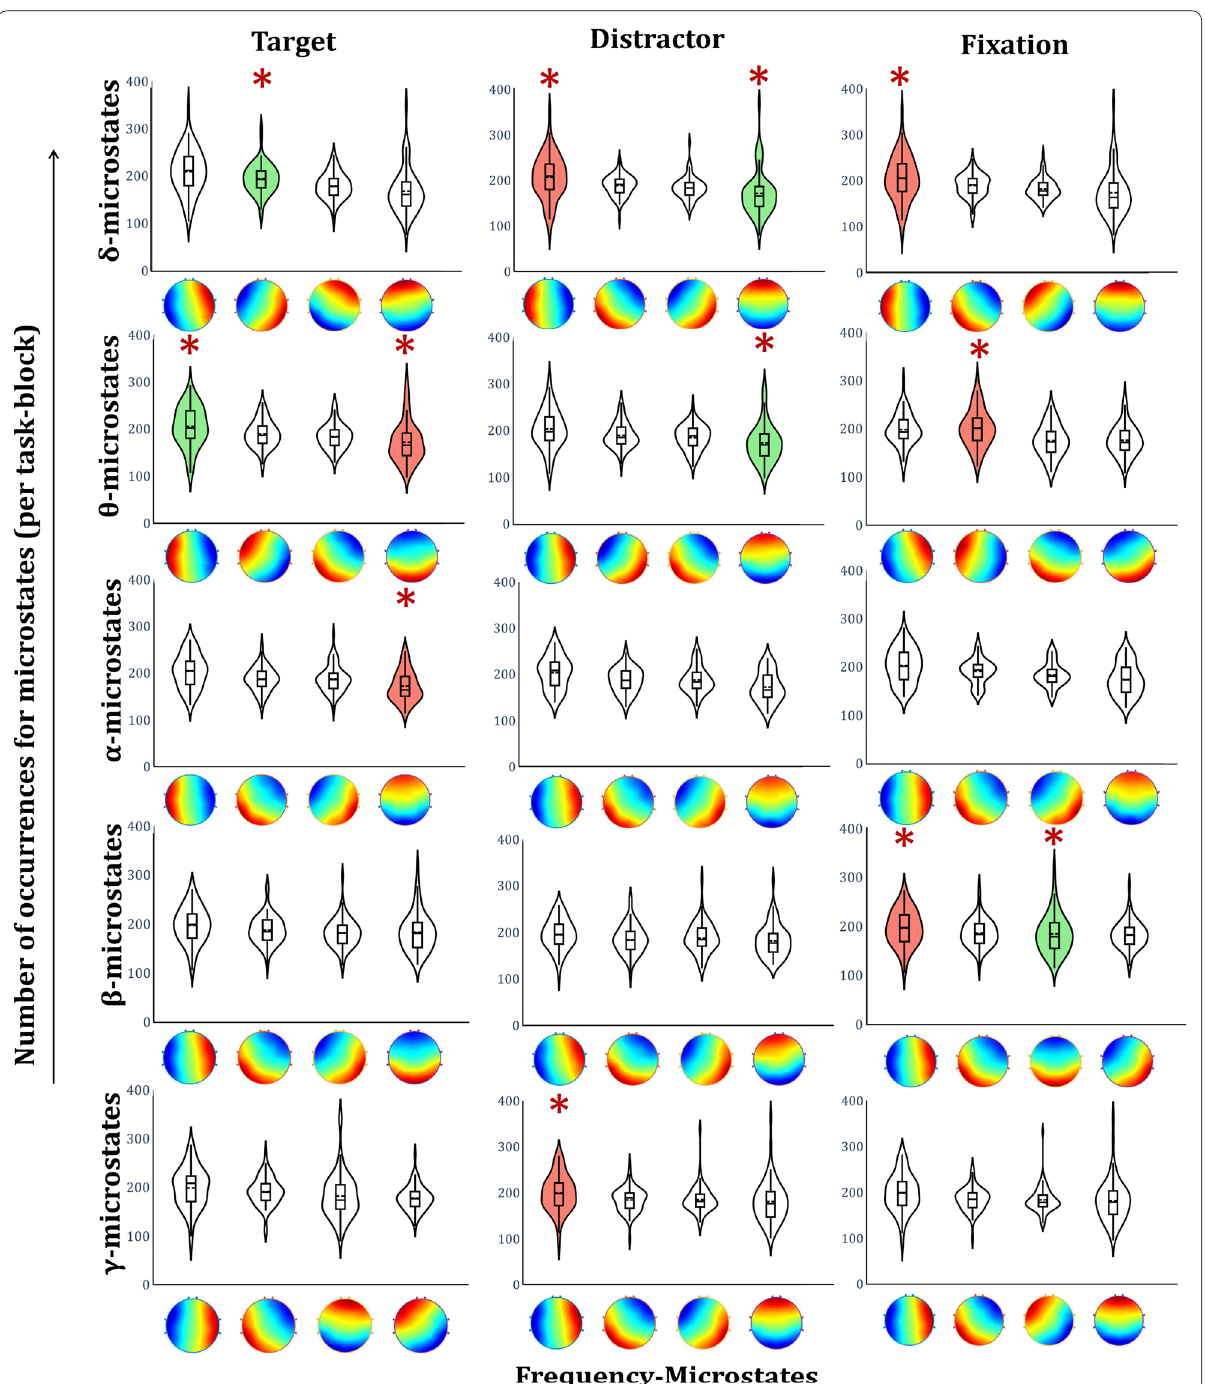
Fig. 5 Estimated metrics of frequency-microstates. The violin graph plots the mean occurrence of each frequency-microstates for each frequency band. The violin plot’s green and red color shades reveal the correlation (positive and negative) of the number of occurrences of quasi-stable elicitation with the task’s fMRI functional connectivity measures. The red star on violin plots specifies the significance ( p <